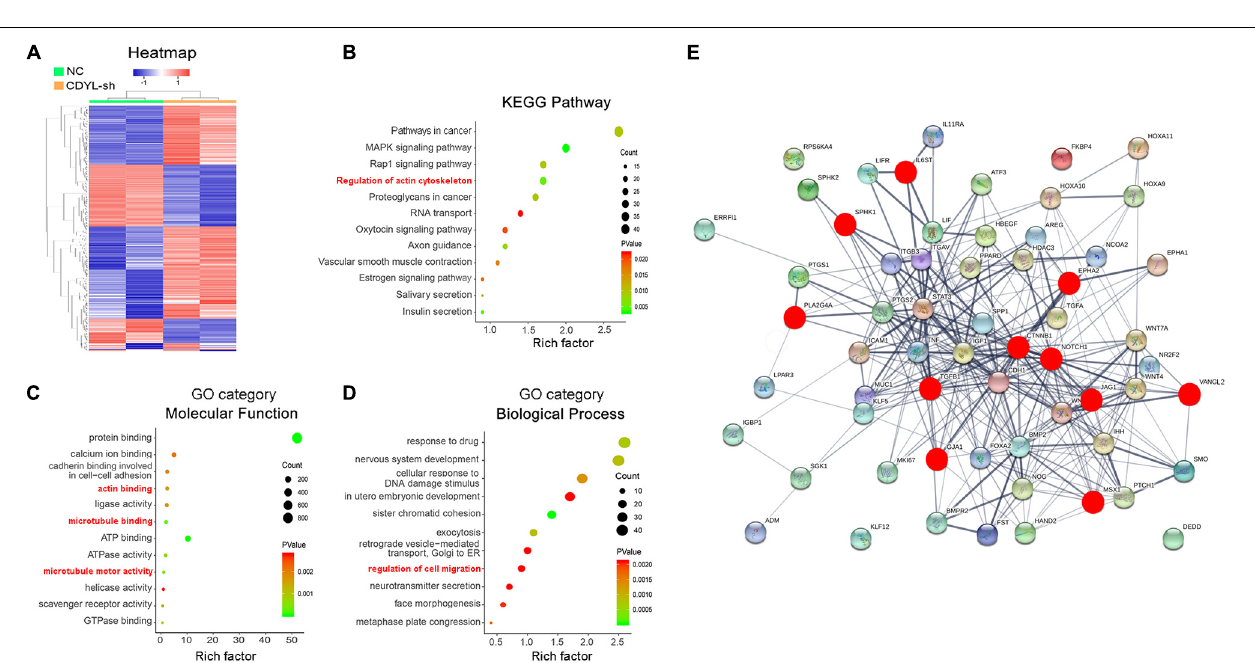
FIGURE 3 | CDYL knockdown suppressed the cell migration capability in Ishikawa cells. The CDYL-knockdown efficiency was shown by Western blot analysis (A) and densitometric quantification (B) . (C) Wound healing assay was used to examine the effect of CDYL silencing on cell migration. (D) The histograms show the quantitated percentage of wound closure. Bar = 100 µ m. N = 3. All data are presented as mean ± SD. * P < 0.05; ** P < 0.01; *** P < 0.001.